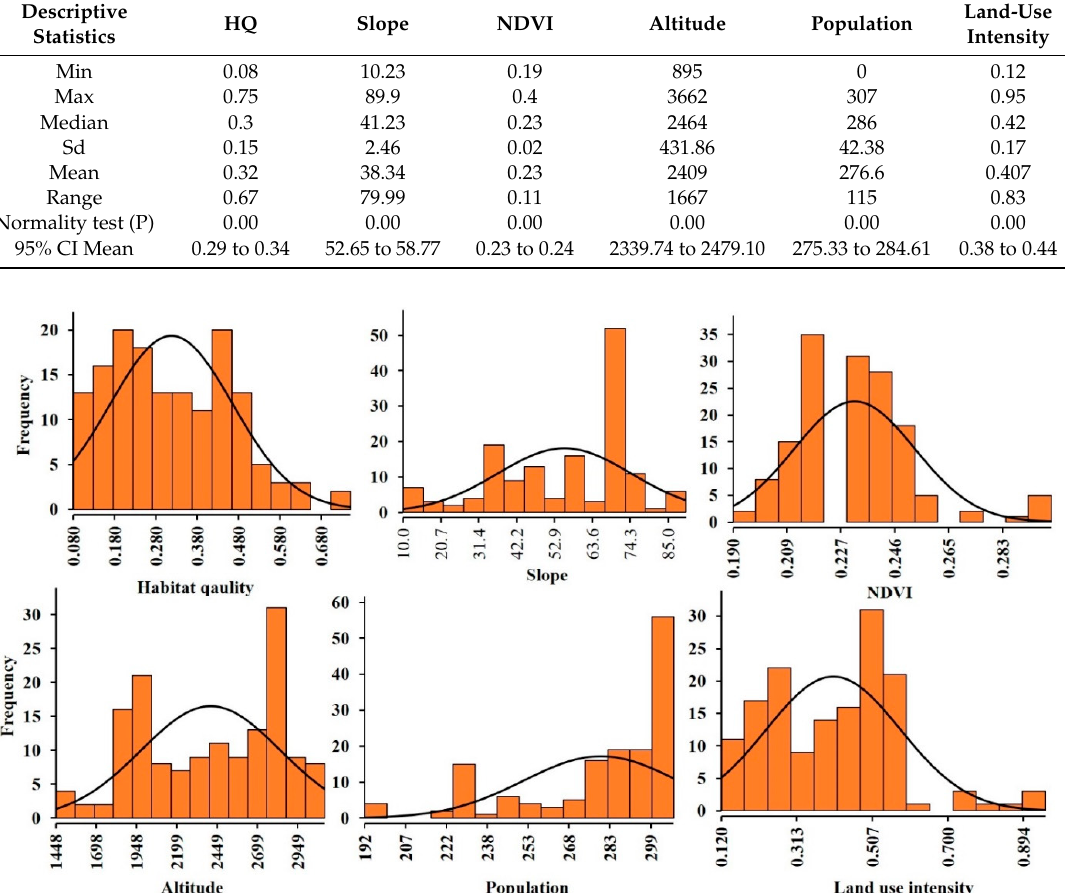
Table 12. Descriptive statistics of the impact factors.